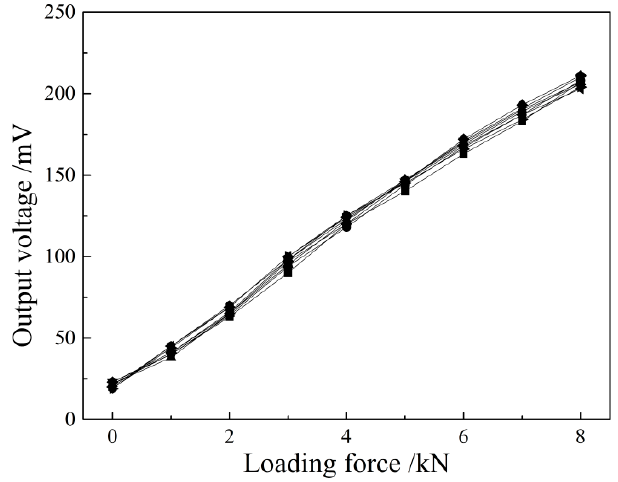
Figure 9. The output voltage with loaded stress of Q235 by repetitive experiment.